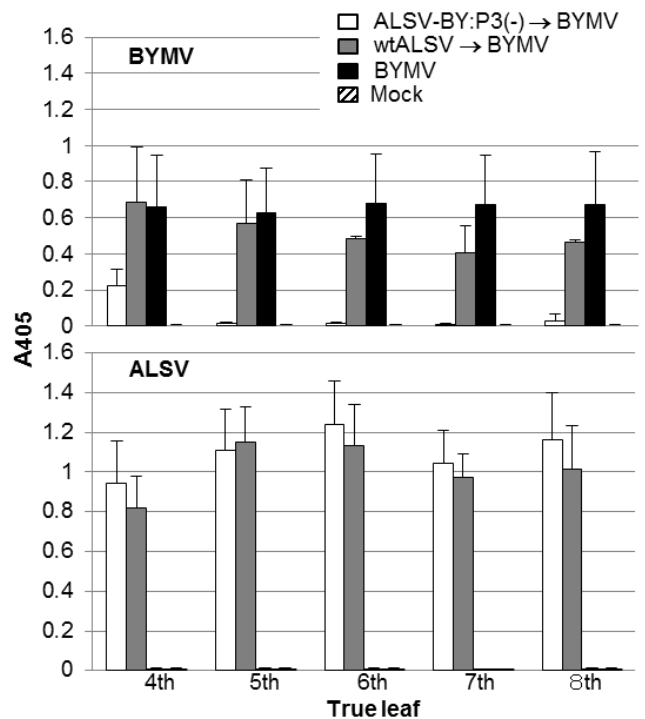
Figure 2. Enzyme-linked immunosorbent assay measuring the accumulation of Bean yellow mosaic virus (BYMV) and Apple latent spherical virus (ALSV) in pea leaves pre-inoculated with ALSV vaccine (ALSV-BY:P3(−) or wtALSV, followed by challenge inoculation with BYMV-GFP at 14 days post-inoculation. The experimental BYMV series BYMV shows plants not pre-inoculated with ALSV